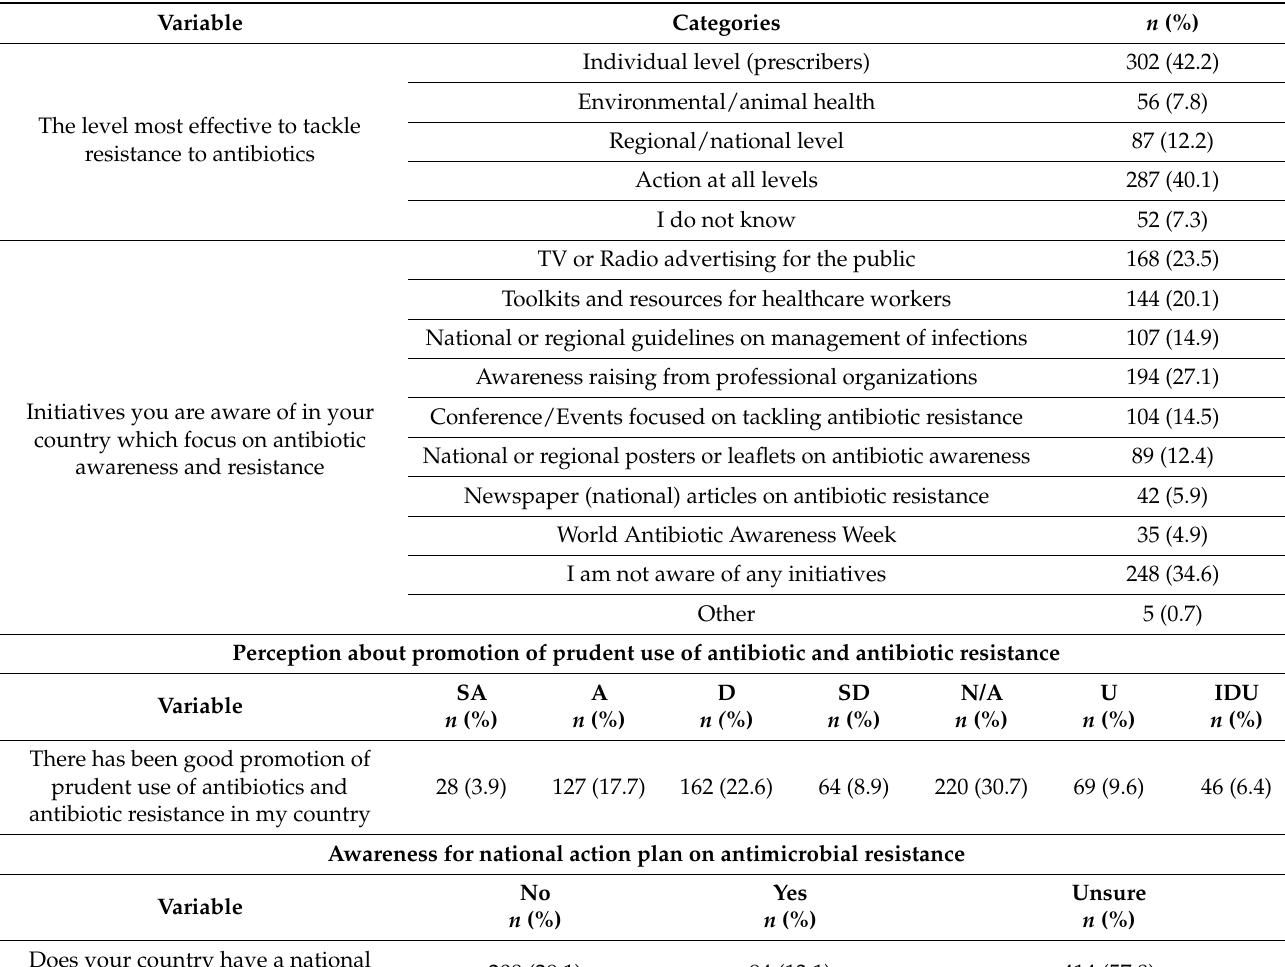
Table 6. National policies and initiatives that are focused on antimicrobial resistance.